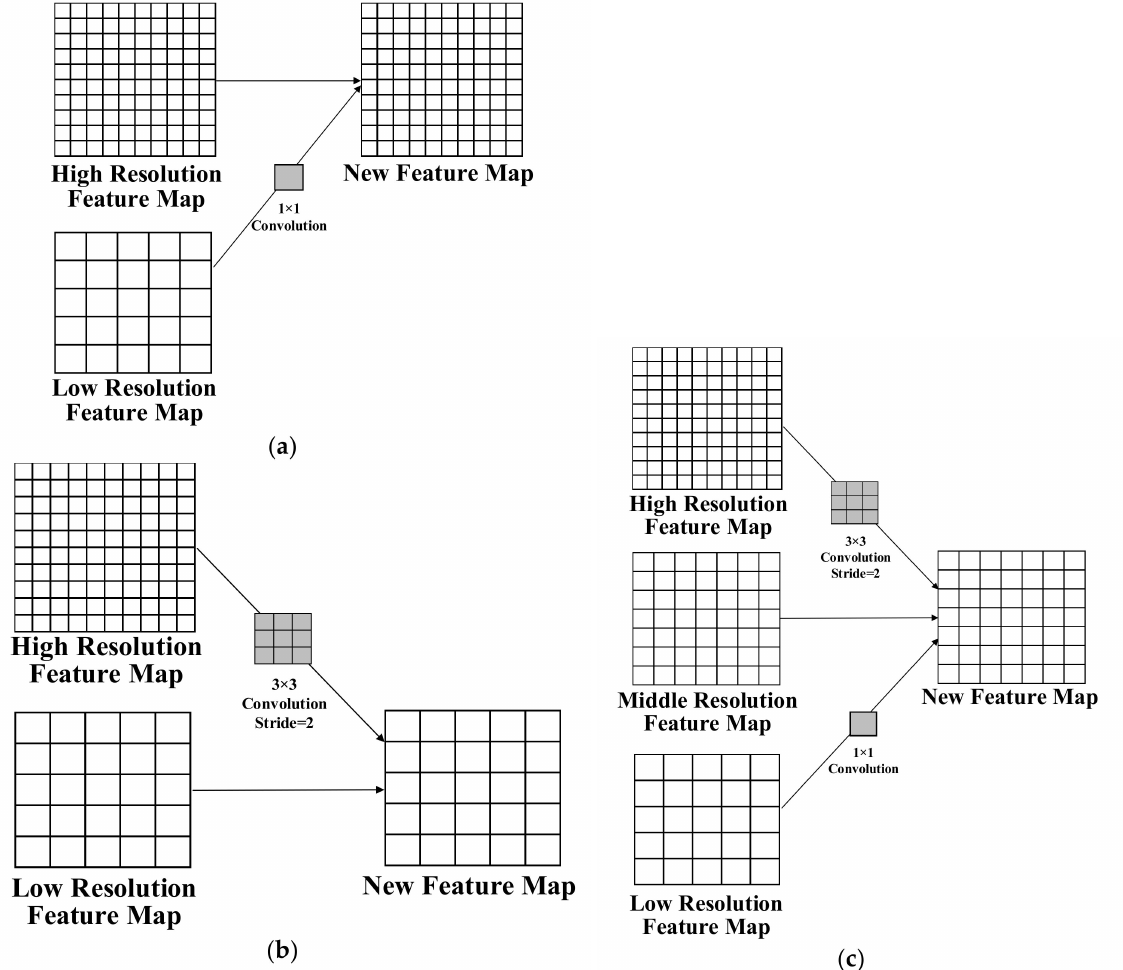
Figure 5. Three types of feature fusion methods. ( a ) Diagram of the high-resolution feature map retaining the same number of channels as the low-resolution feature map as the high-resolution feature map via convolution. ( b ) Diagram of the low-resolution feature map using convolution to downsample the high-resolution feature map to the same size as the low-resolution feature map. ( c ) Diagram of the moderate-resolution feature map by upsampling and interpolating the low-resolution feature